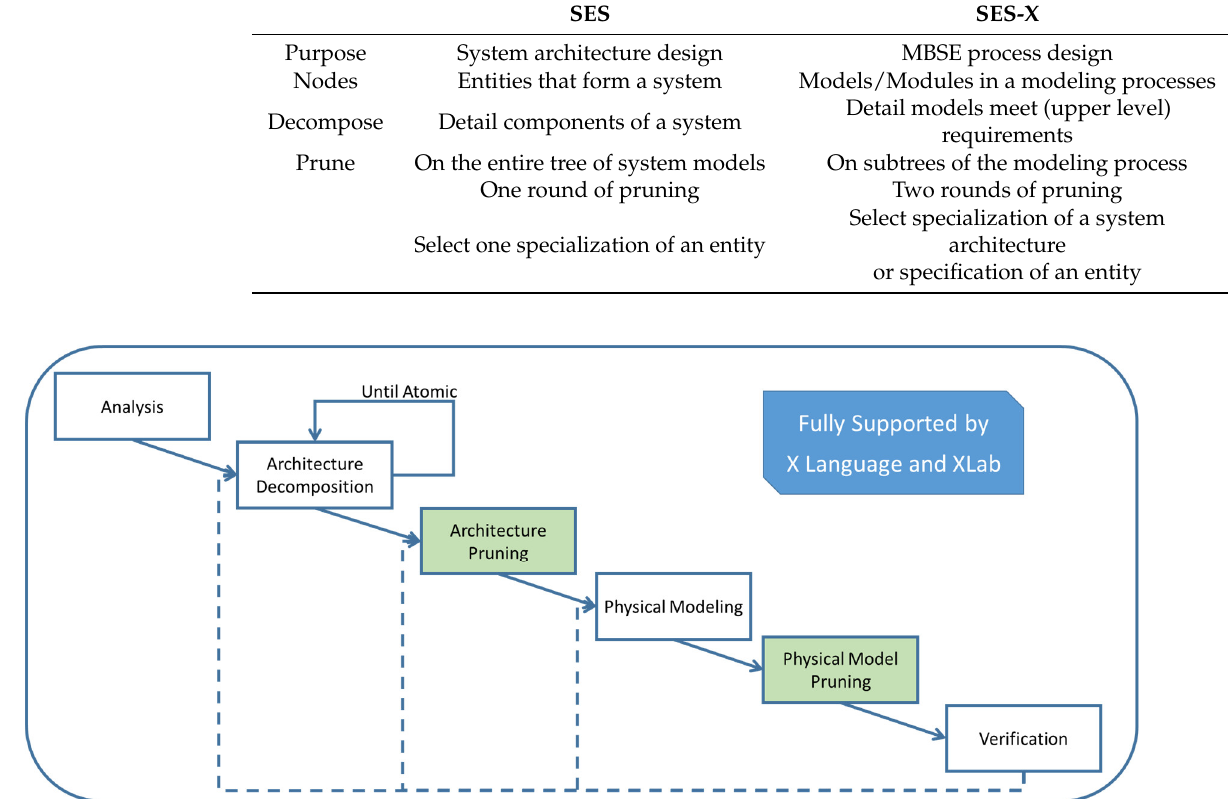
Table 1. Difference between SES and SES-X.